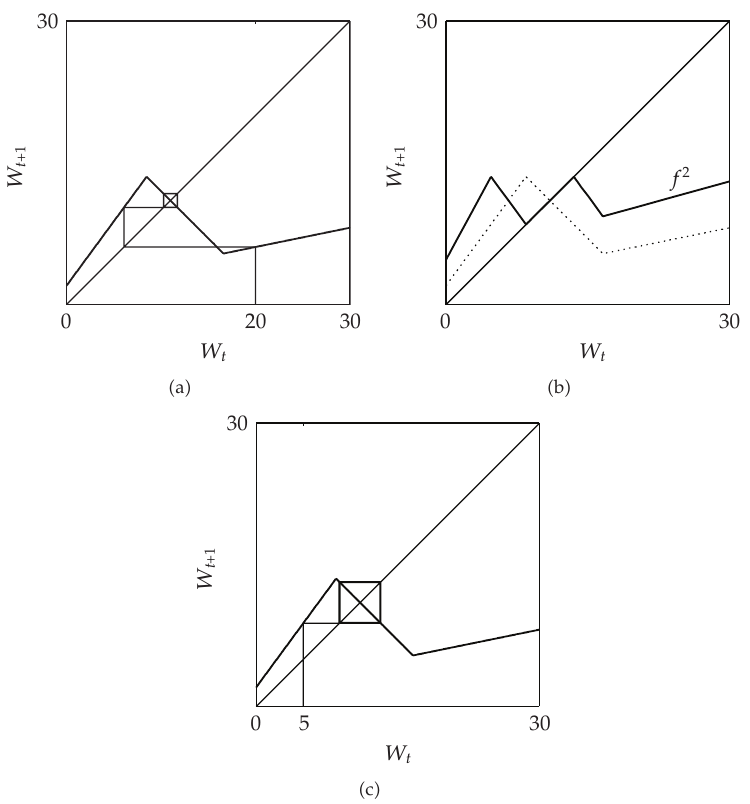
Figure 4: Repelling period-2 orbits for μ (cid:9) 4 . 9. In (cid:3) a (cid:4) , we have a first cycle two for the initial condition W 0 (cid:7) 20 that is di ff erent from the one in (cid:3) c (cid:4) for W 0 (cid:7) 5. In (cid:3) b (cid:4) , the fixed invariant interval of f 2 is